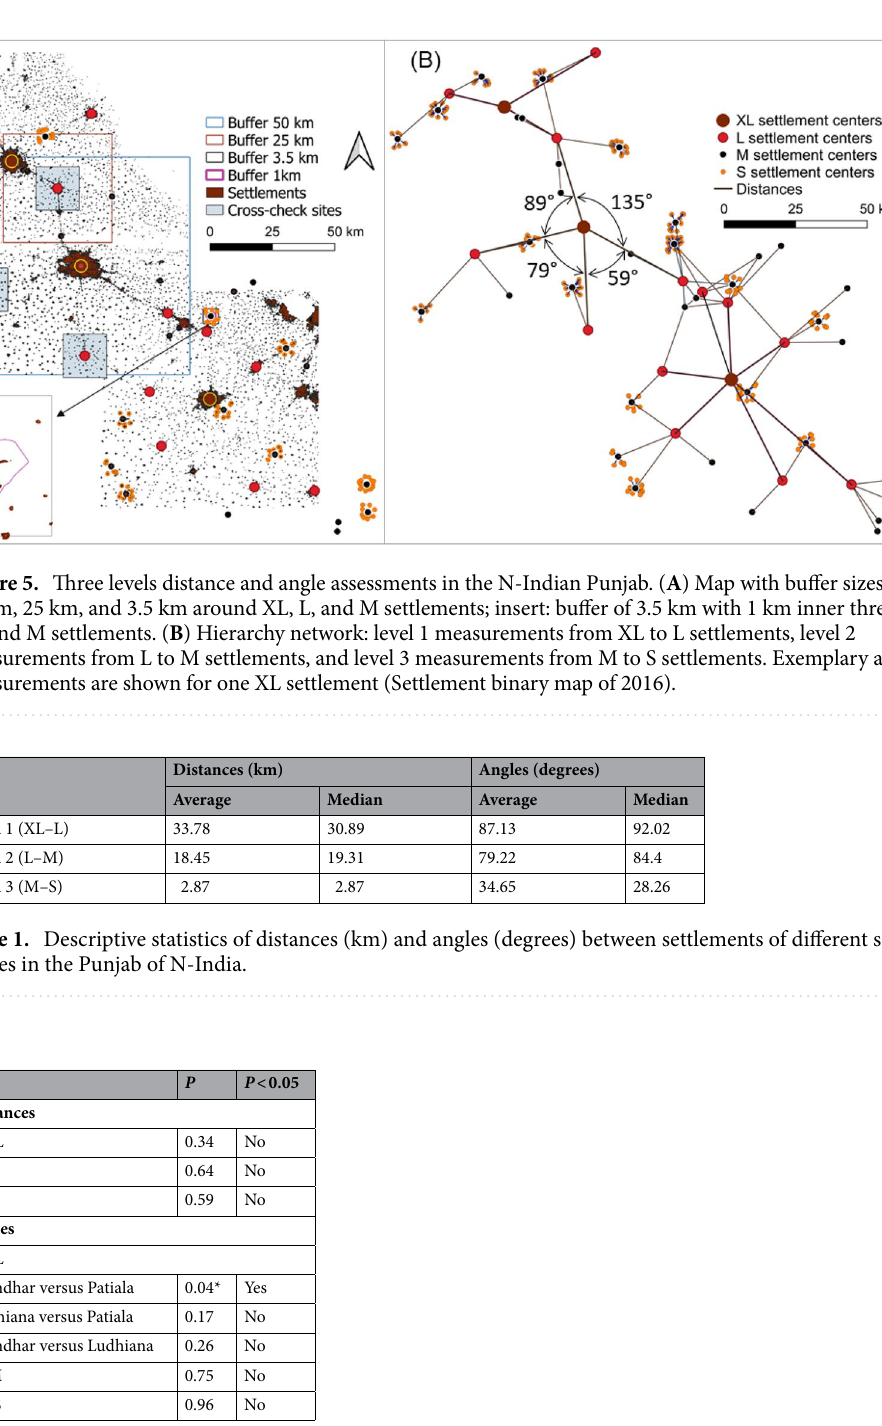
Table 2. Statistic of distances and angles from the larger to next smaller size class at three levels in the Punjab region of N-India. *Differ from overall frequency at p < 0.05.